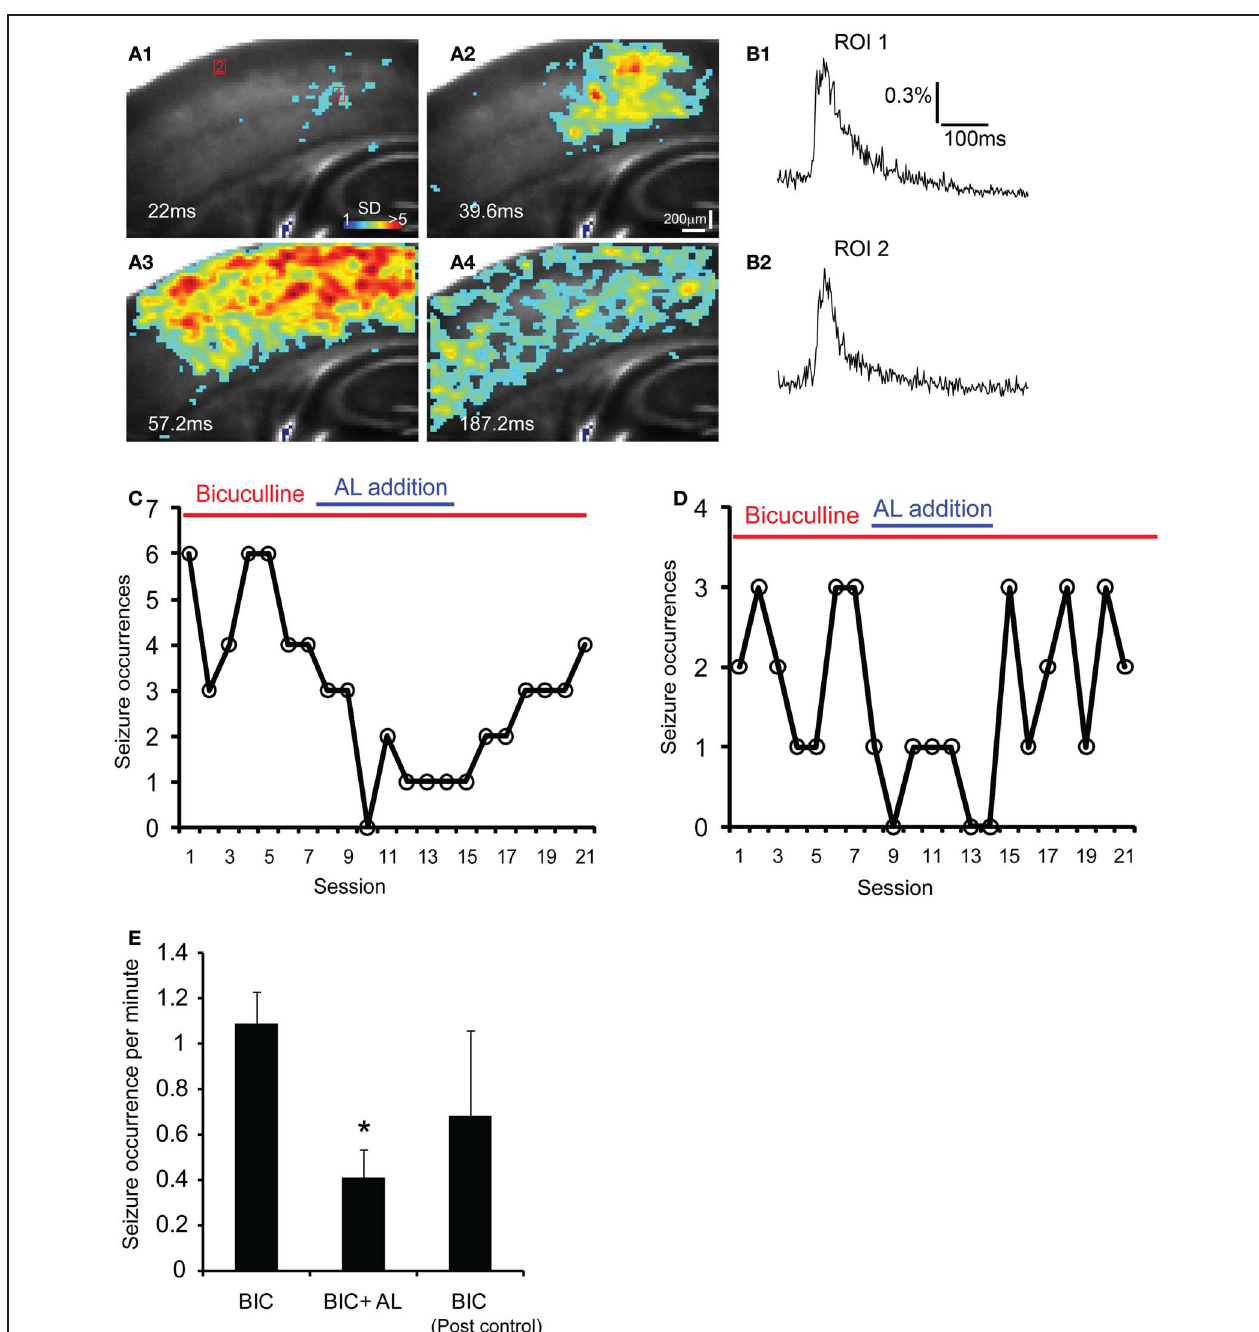
FIGURE 7 | The AlstR system suppresses the occurrence of bicuculline-induced spontaneous seizure-like activity. (A1–A4) Time series data of VSD imaging of bicuculline-induced spontaneous seizure-like activity in a Emx1-Cre: AlstR mouse slice. Specific time from the estimated seizure onset is labeled on the image. The color scale codes VSD signal amplitude expressed as SD multiples above the mean baseline. (B1, B2) The time course of VSD signal (in the percent change of pixel intensity [ (cid:3) I / I % ] ) from the two ROIs (1 and 2) marked in A1 is plotted, respectively. Note that ROI 1 is close to the seizure initiation site. (C, D) The plots of seizure occurrences per imaging session (126 seconds per session)